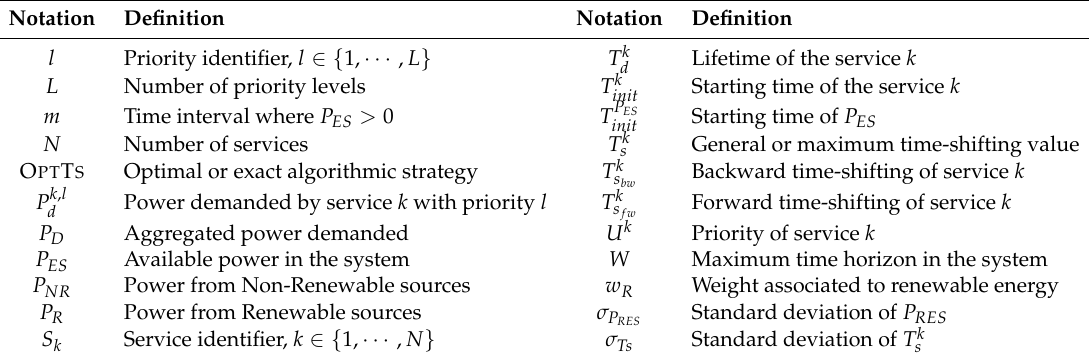
Table 2. List of notations and corresponding